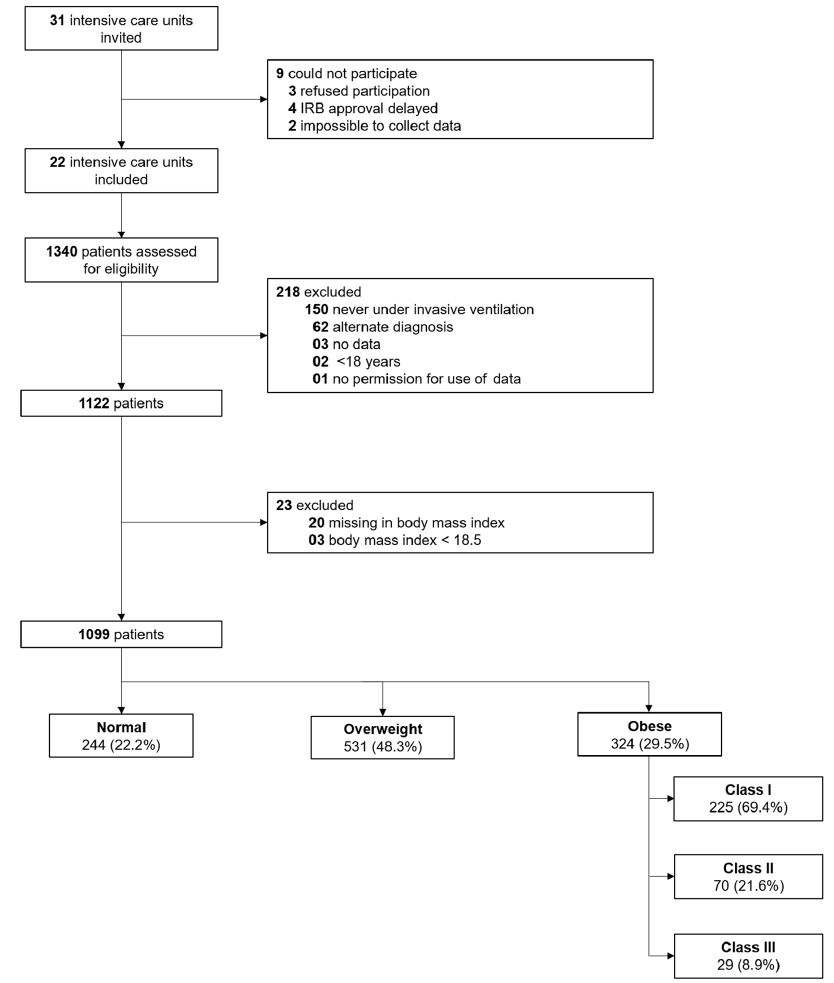
Figure 1. Study profile. Follow-up to 90 days was complete in 996 patients. IRB: Institutional Review Board.